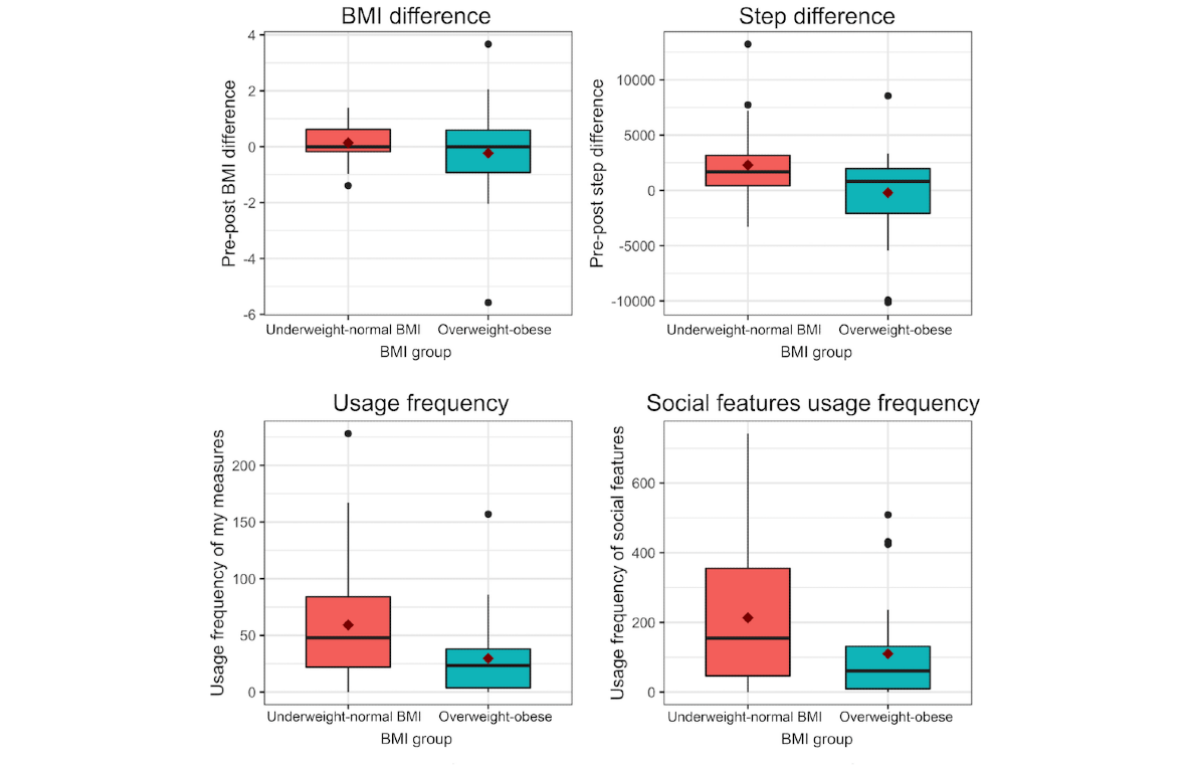
Figure 1. Box plots of pre-post BMI difference, pre-post step count difference, My measures use frequency, and social features use